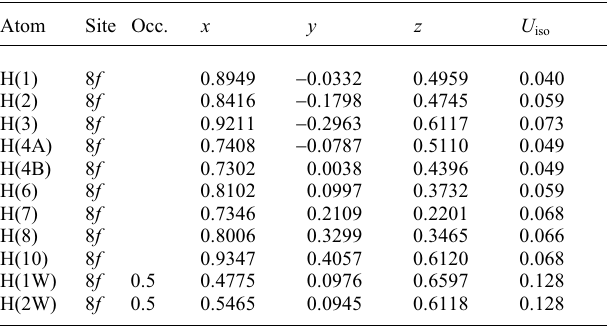
Table 2. Atomic coordinates and displacement parameters (in Å 2 )